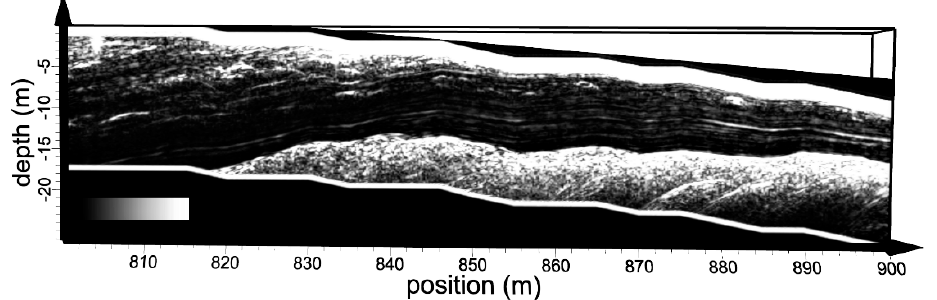
Figure 19. An example of GPR data from an alpine ice patch after attribute analysis (instantaneous amplitude envelope) and topographic corrections. This offers a more intuitive image with truer dimensions. This is the same profile as shown in Figure 18.